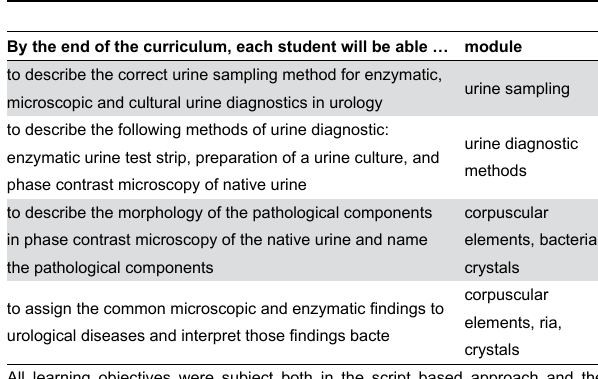
Table 1. Major cognitive learning objectives of the curriculum on "Phase contrast microscopic urinalysis on native